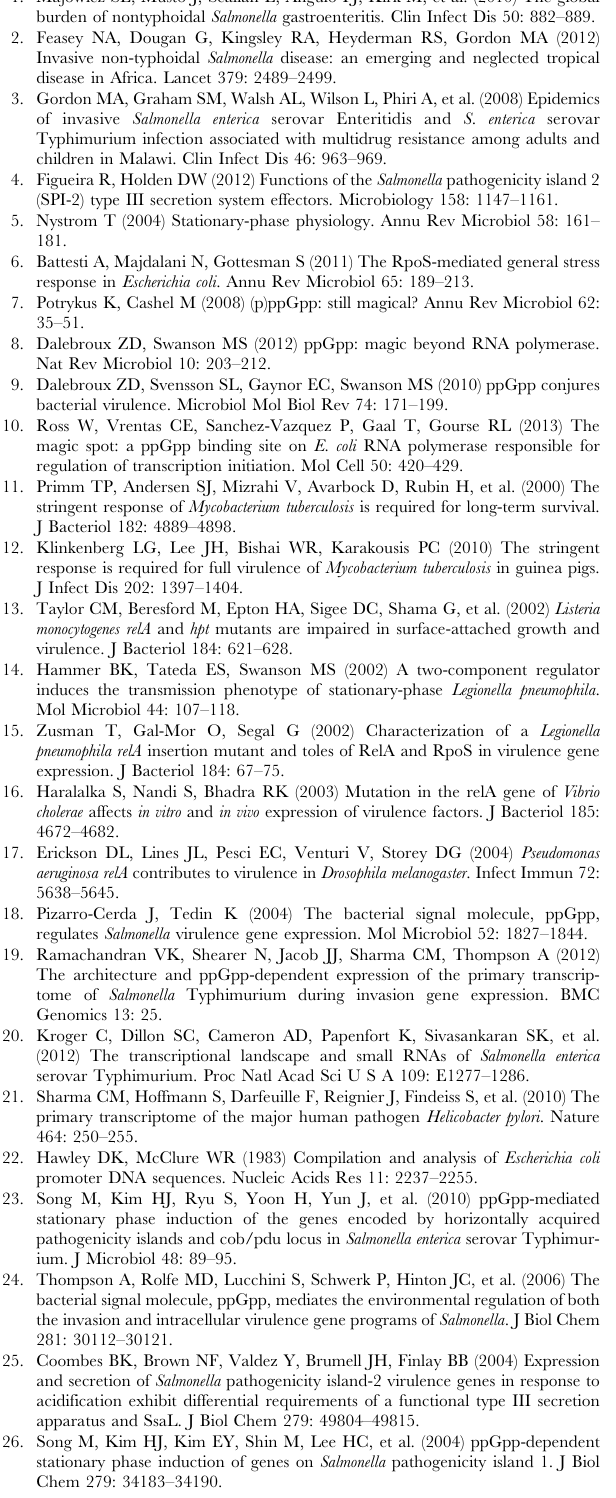
Table S8 TSSs and ppGpp-dependent expression of known and predicted sRNAs that have been validated by Northern blot